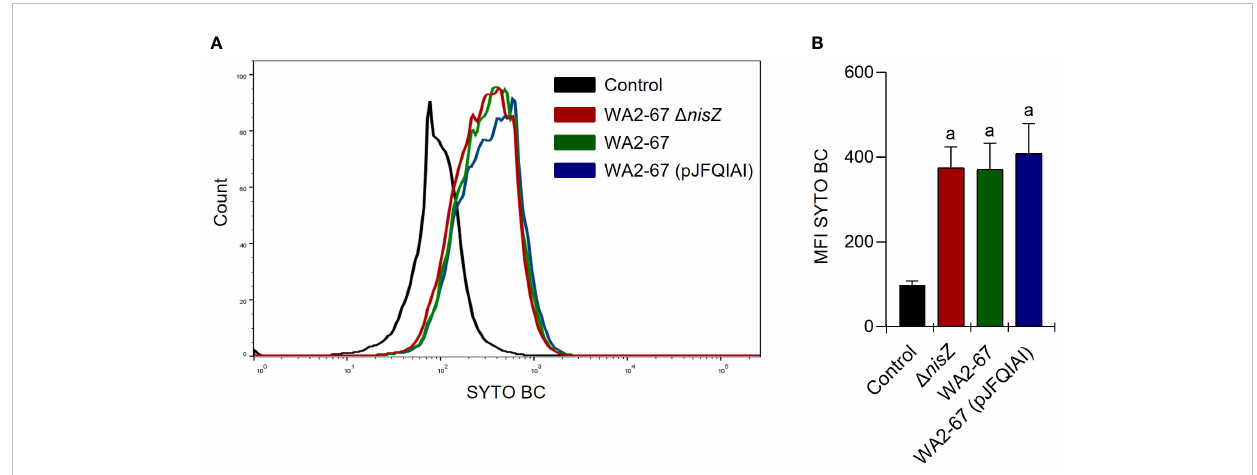
FIGURE 2 Adherence of L. cremoris strains to RTgutGC cells. RTgutGC cells were incubated with the different strains at 20°C for 24 h. Control cells without bacteria were similarly treated. Adherence was then estimated by fl ow cytometry. Representative histograms (A) are shown along with a graph (B) representing the mean values of MFI calculated for each peak, shown as mean + SD (n = 12). The letter (a) represents adherence values signi fi cantly different to control